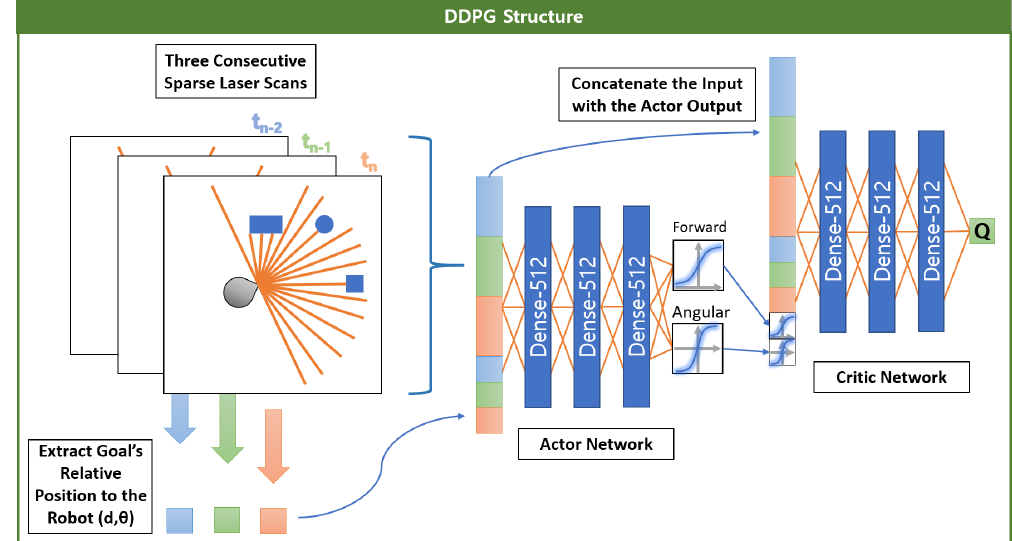
Figure 9. The Deep Deterministic Policy Gradients (DDPG) structure used to approximate an autonomous navigation policy.